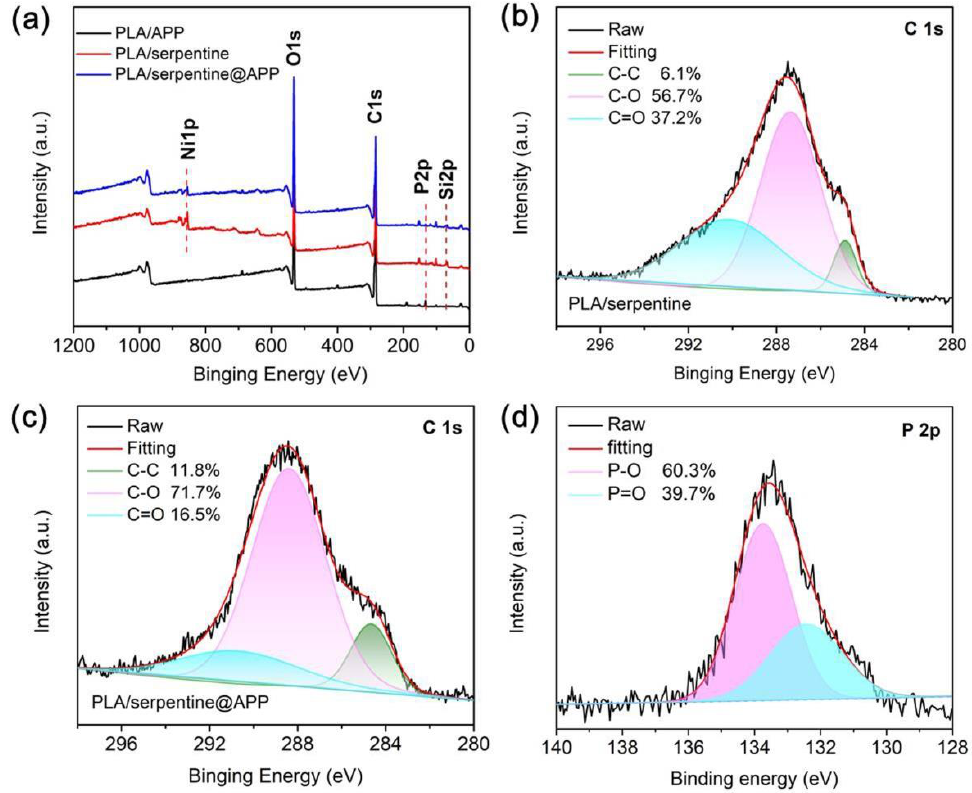
Figure 8. XPS spectra of the char residues after cone calorimeter test. ( a ) Full scanning spectra, ( b ) C 1s spectrum of PLA/serpentine; ( c ) C 1s, and ( d ) P 2p spectra of PLA/serpentine@APP. The graphitization degree of the char residues was analyzed by Raman spectra [38].